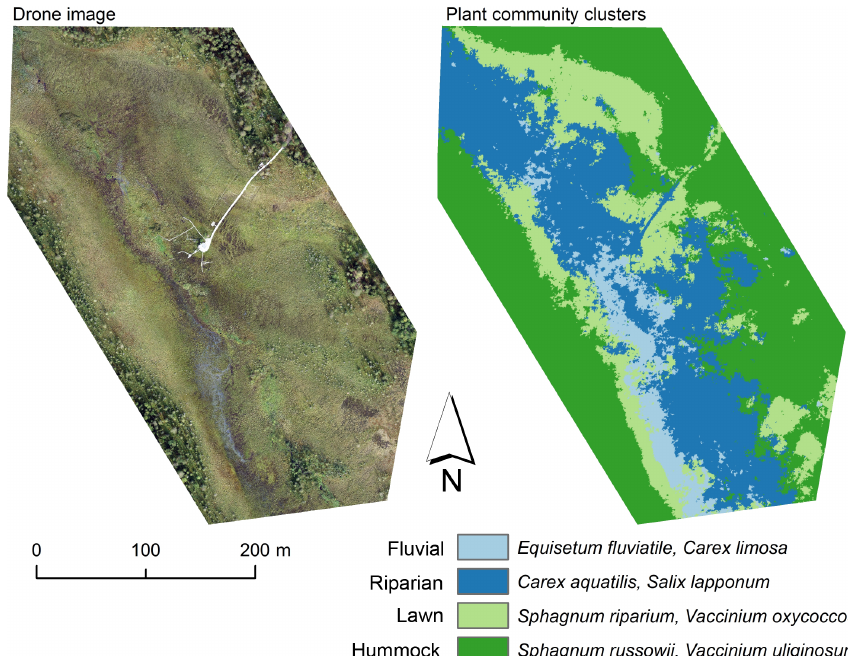
Figure A2. Drone image and a map of plant community clusters over the study area. The cluster map was produced with the multi-source remote sensing data listed in Räsänen et al. (2020). We calculated remote sensing features for the vegetation plots and vegetation patches delineated from the drone image with mean-shift segmentation in Orfeo ToolBox (Grizonnet et al., 2017). We trained a random forest classification (Breiman, 2001) with the vegetation plot data and predicted the classification for the vegetation patches. Classification accuracy (random forest out-of-bag estimate) was 61%.